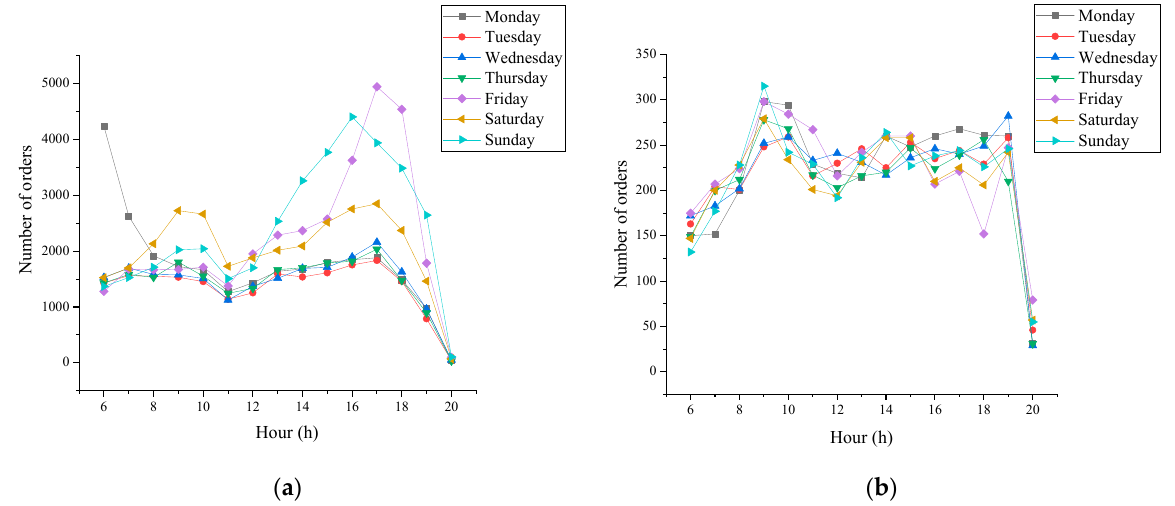
Figure 2. ( a ) Distribution of departure times for ridesplitting rides; ( b ) Distribution of departure times for single rides.